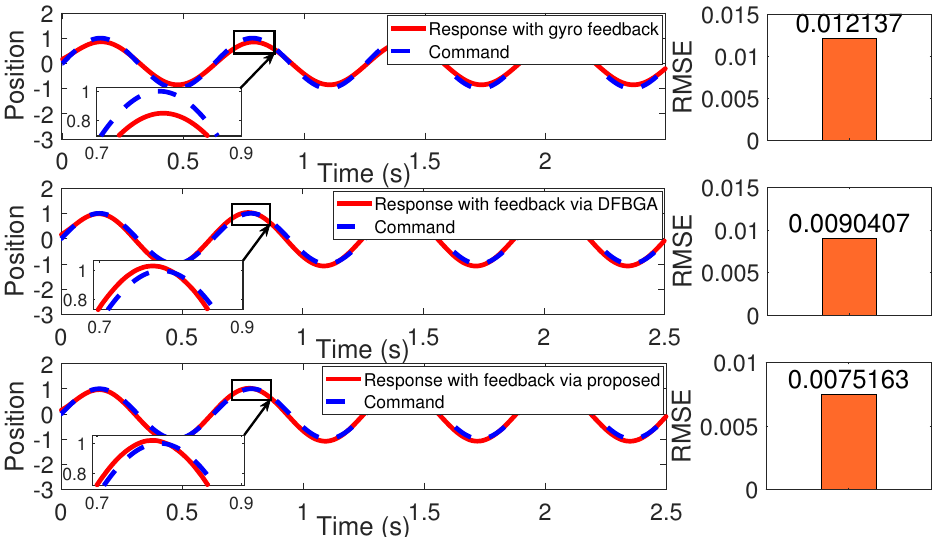
Figure 8. Application in motion control. The first subfigure is the simulated original-gyro signal feedback, the second subfigure is the feedback signal processed by DFBGA, the third subfigure is the feedback signal processed by proposed